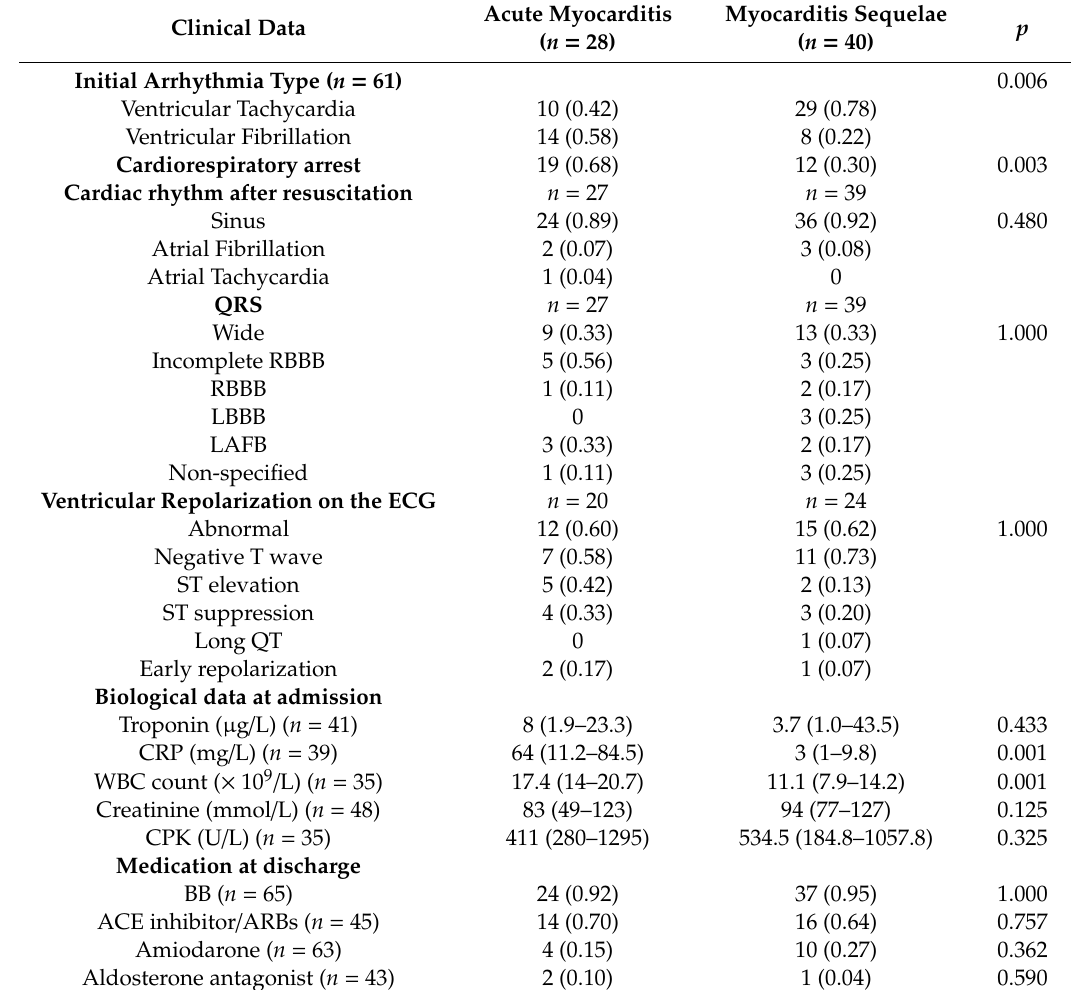
Table 2. Clinical data. ACE: angiotensin-converting enzyme; ARBs: angiotensin II receptor blockers; BB: beta-blocker; CPK: creatine phosphokinase; ECG: electrocardiogram; LBBB: left-bundle branch block; RBBB: right-bundle branch block; LAFB: left anterior fascicular block; WBC: white blood